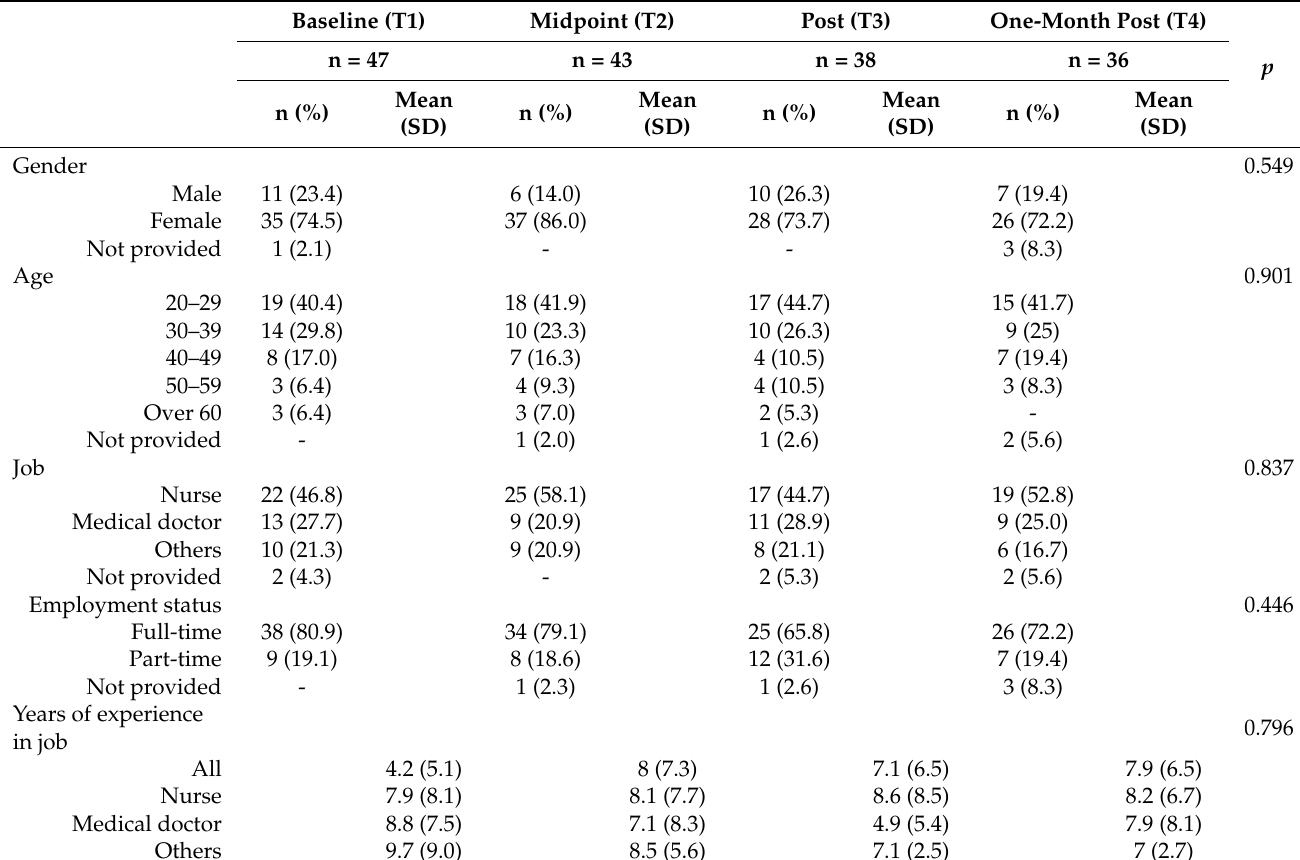
Table 1. Study participant demographics at each time point in a psychiatric ward in a Japanese